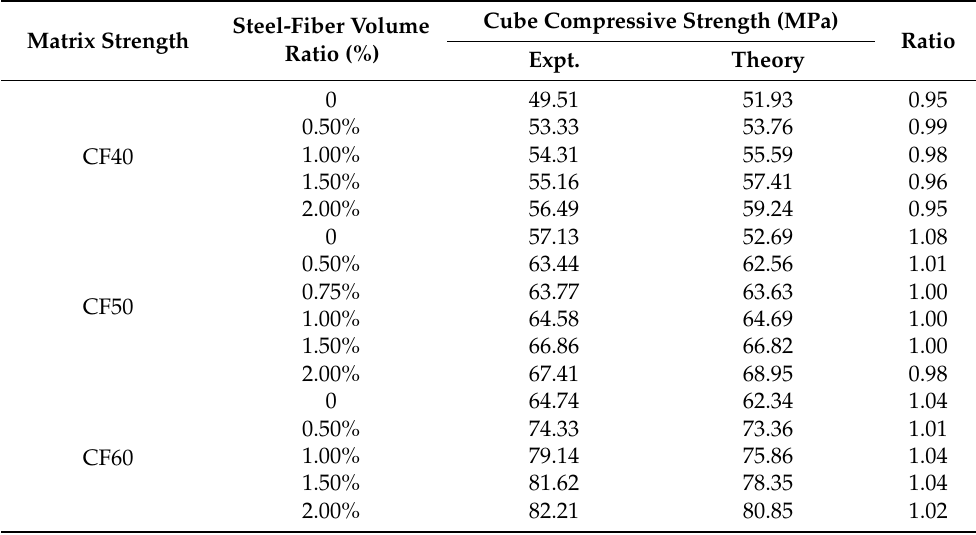
Table 6. Experimental and theoretical results for cube compressive